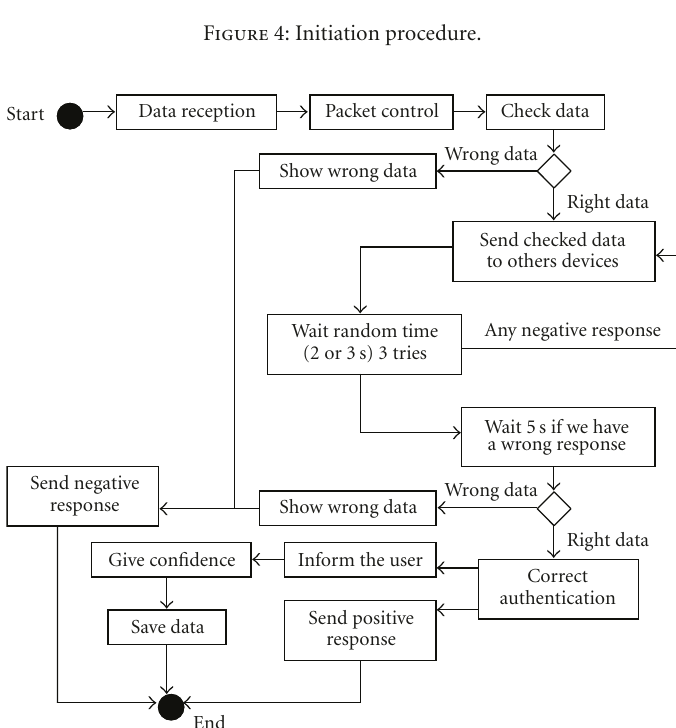
Figure 4: Initiation procedure.